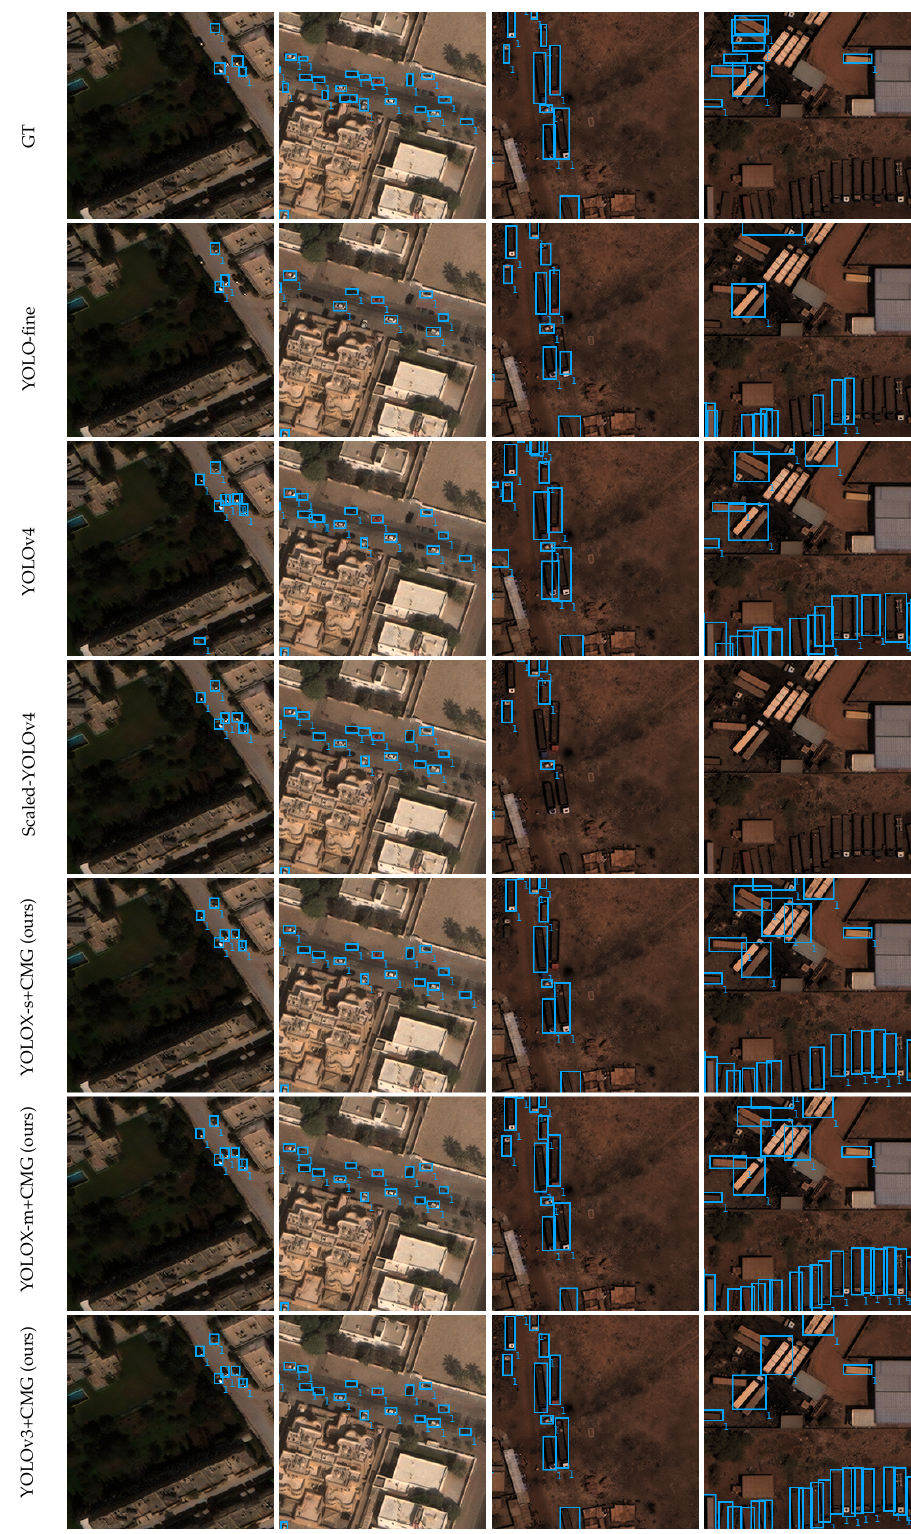
Figure 8. Qualitative results of our methods and state-of-the-art methods on xView. The number and color of each box indicates the vehicle class. The last column shows a failure case. Our method could recognize objects of various shapes and would wrongly detect objects of extreme resemblance (although this might have been because of the faulty